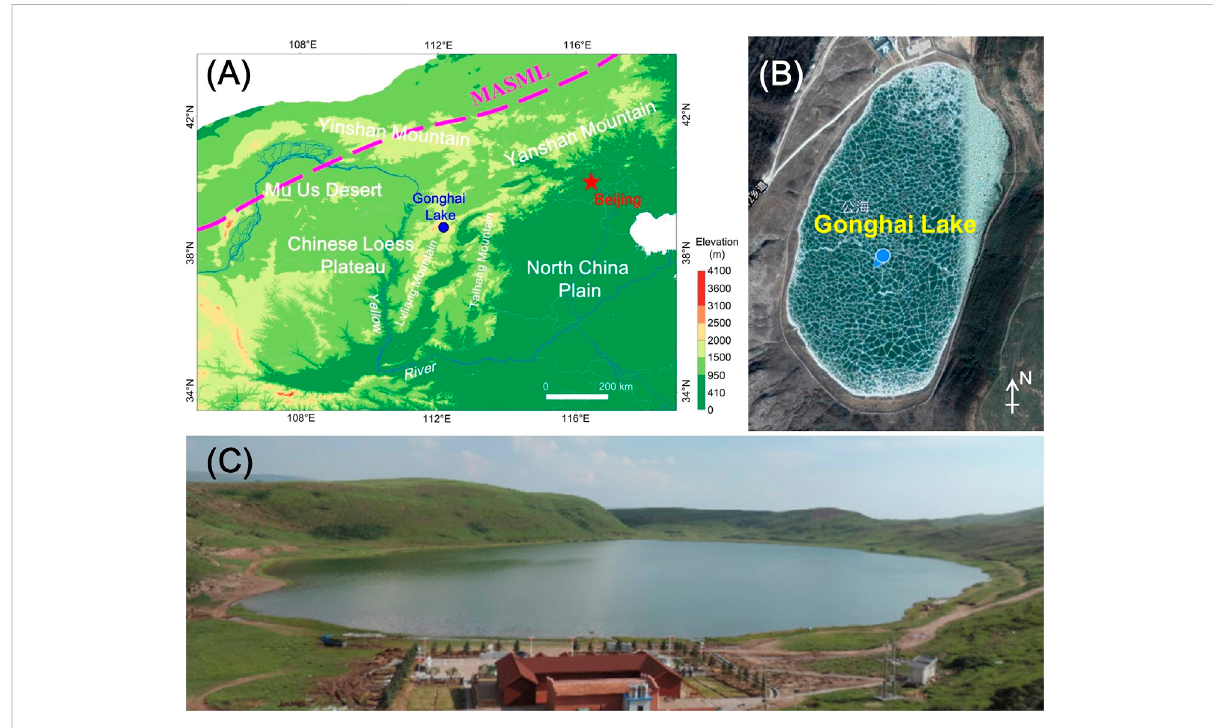
FIGURE 1 Thestudyarea: (A) locationofGonghaiLake; (B) coresamplingsite;and (C) imageofGonghaiLake(Chenetal.,2017).Themagentadashedline is the modern Asian summer monsoon limit (MASML, after Liu et al., 2014).